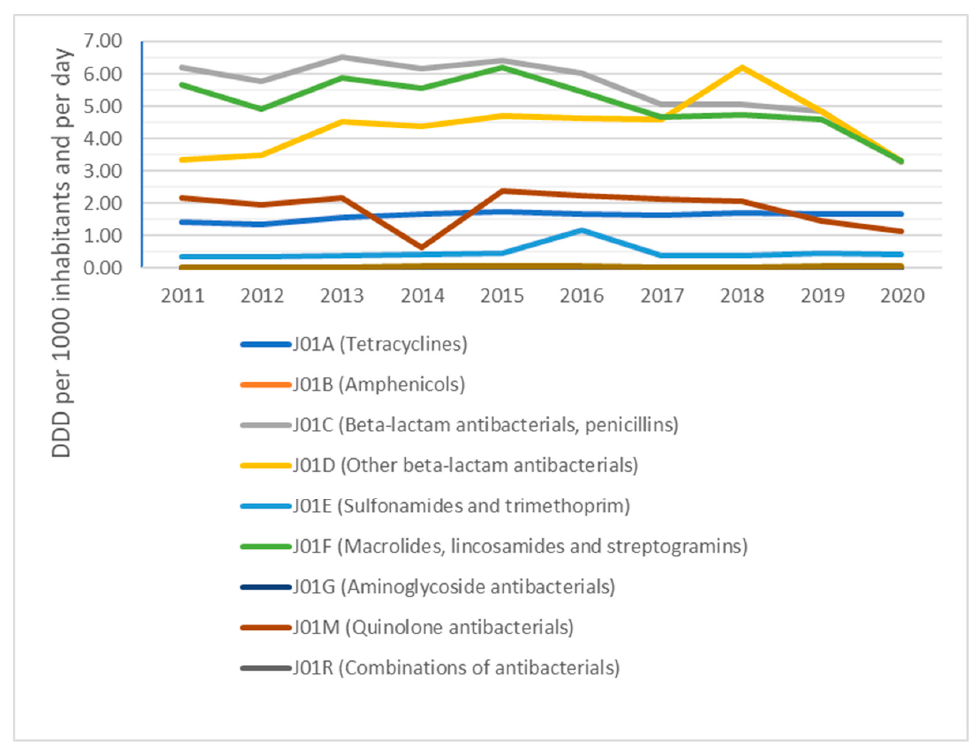
Figure 1. Antibiotic consumption (ATC group J01) in the community.